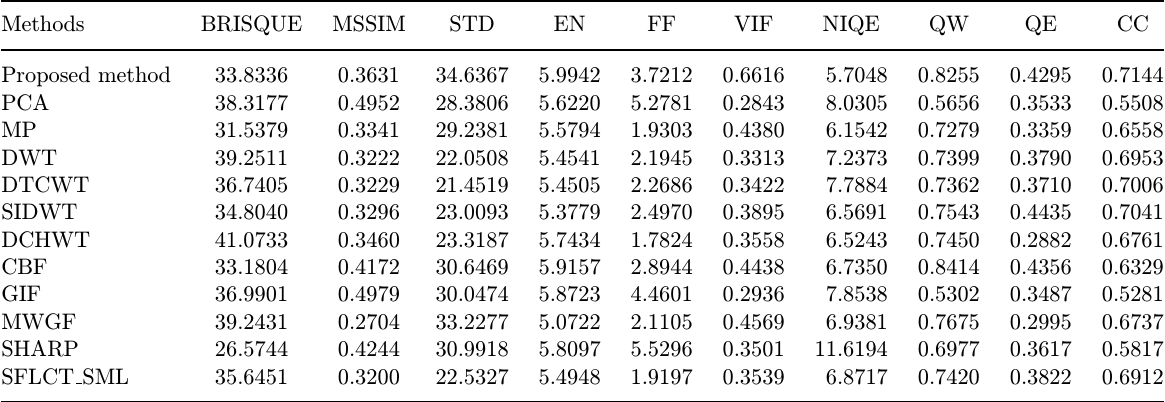
Table 1. Performance comparison for the ¯rst group of medical